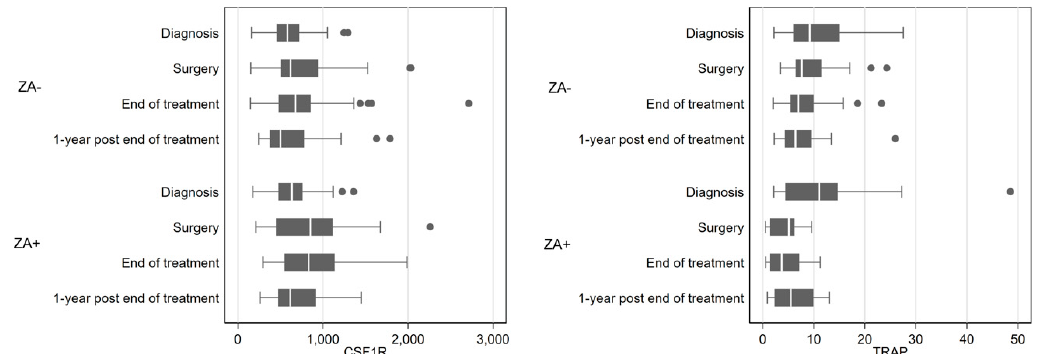
Figure 2. CSF-1R and TRAP serum levels over time for patients who received (ZA+) or not (ZA − ) zoledronic acid.